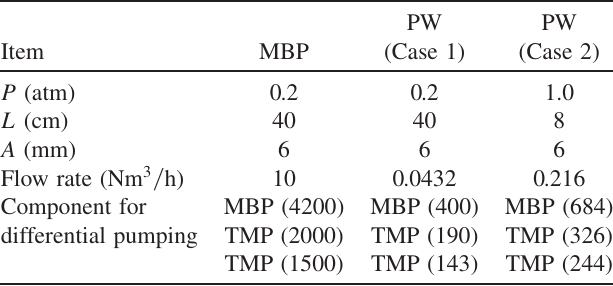
TABLE V. Comparison between the gas stripper systems based on the plasma window (PW) and the big mechanical booster pump (MBP). P , L , and A denote pressure, length, and aperture of the gas cell, respectively. The listed flow rate is that required to maintain the pressure in the gas cell. Components for connecting with the beam vacuum in differential pumping are also listed. Their pump speeds are listed in brackets, in m 3 = h for MBP and in l = s for turbo molecular pump (TMP). Cases 1 and 2 with PW correspond to pressures of 0.2 and 1 atm, respectively.